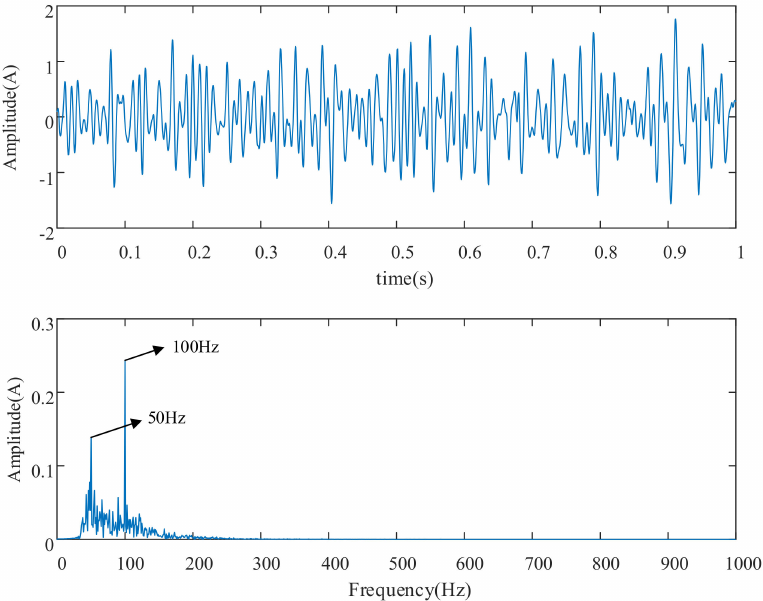
Figure 11. Time − frequency domain waveform of reconstructed signal enhanced by second ACSRS.